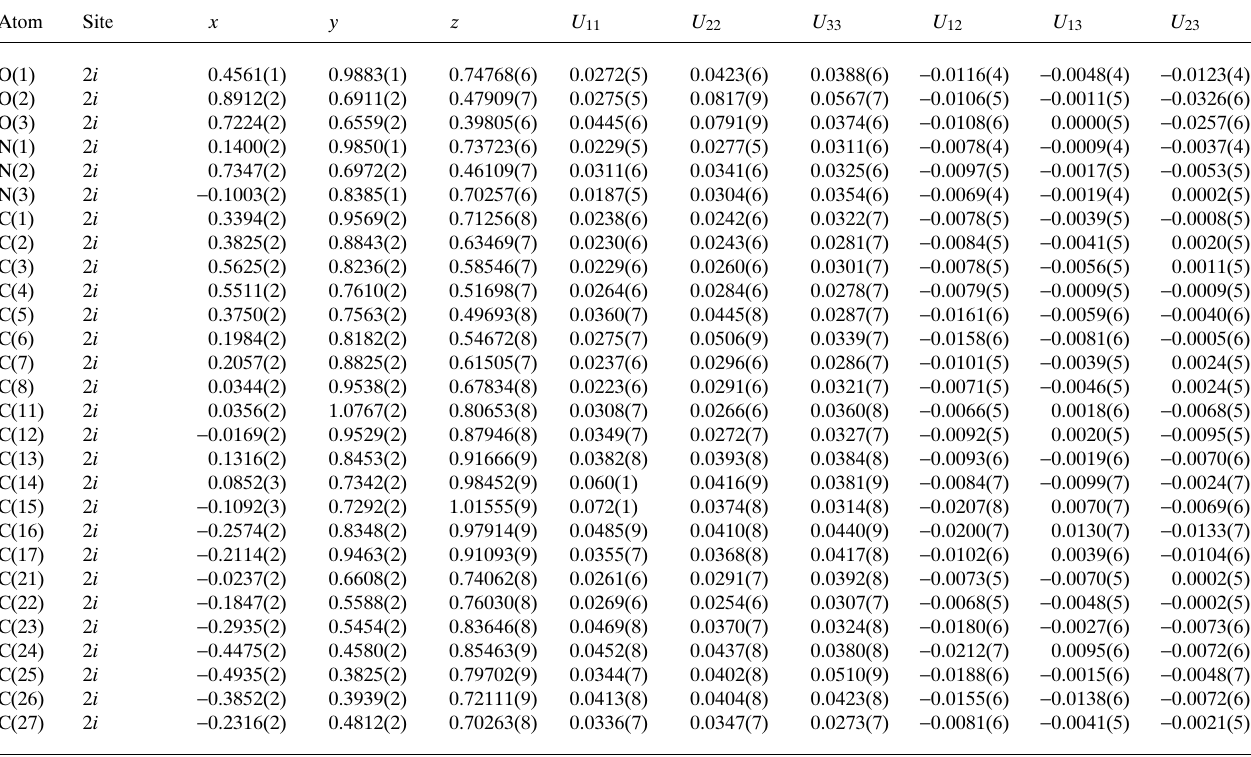
Table 3. Atomic coordinates and displacement parameters (in Å 2 ) .